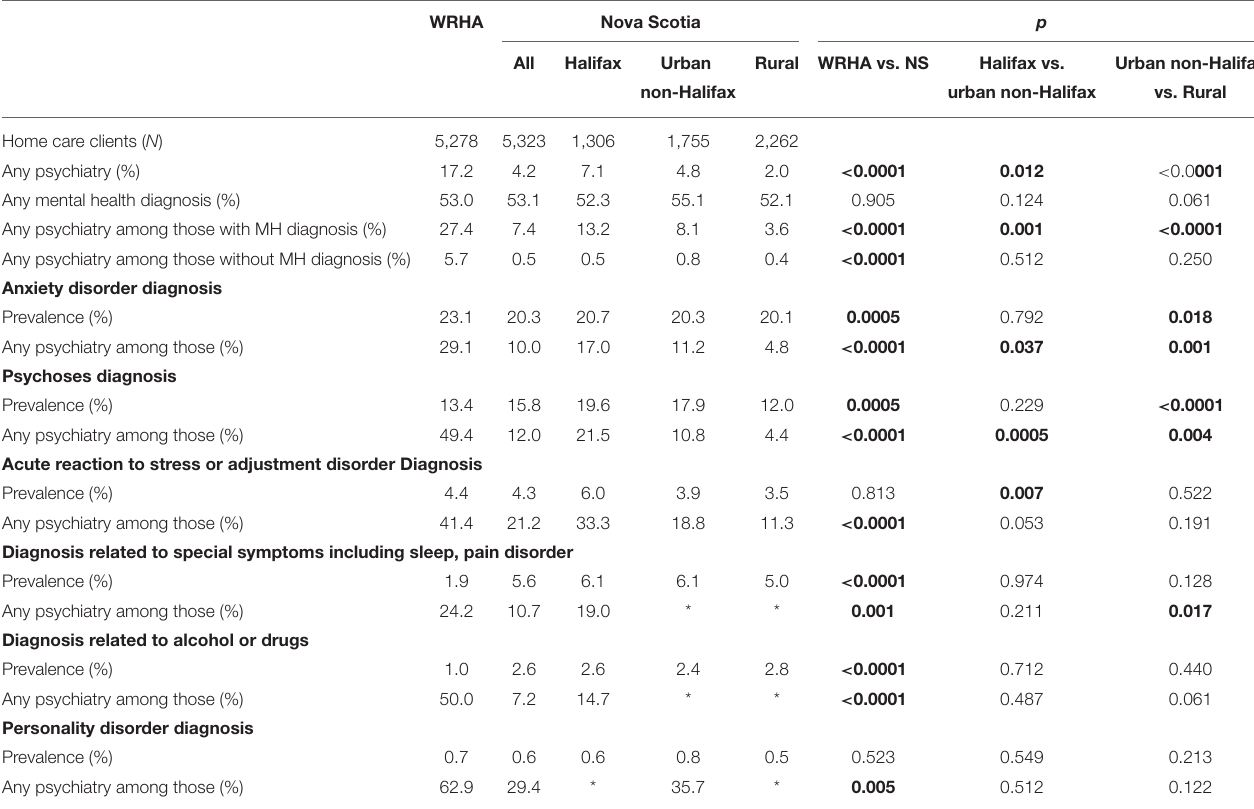
TABLE 4 | Characteristics of HC clients having any psychiatry and/or mental health diagnoses, and by selected diagnostic groups, by province and urban/rural. WRHA Nova Scotia p All Halifax Urban Rural WRHA vs. NS Halifax vs. Urban non-Halifax non-Halifax urban non-Halifax vs.